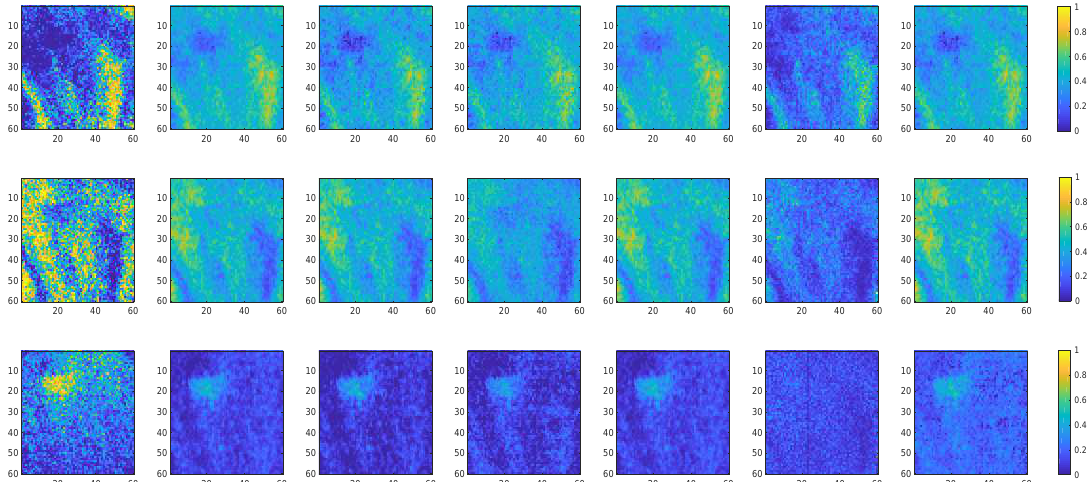
Figure 7. Abundances maps of S 6 . From left to columns: ground-truth, estimated abundances of FCLS, SUnSAL, K-Hype ( G ), NDU ( G ), IIKNMF ( G ), proposed ( G ). From top to bottom rows: distributions of blue quartz sand, red quartz sand and green quartz